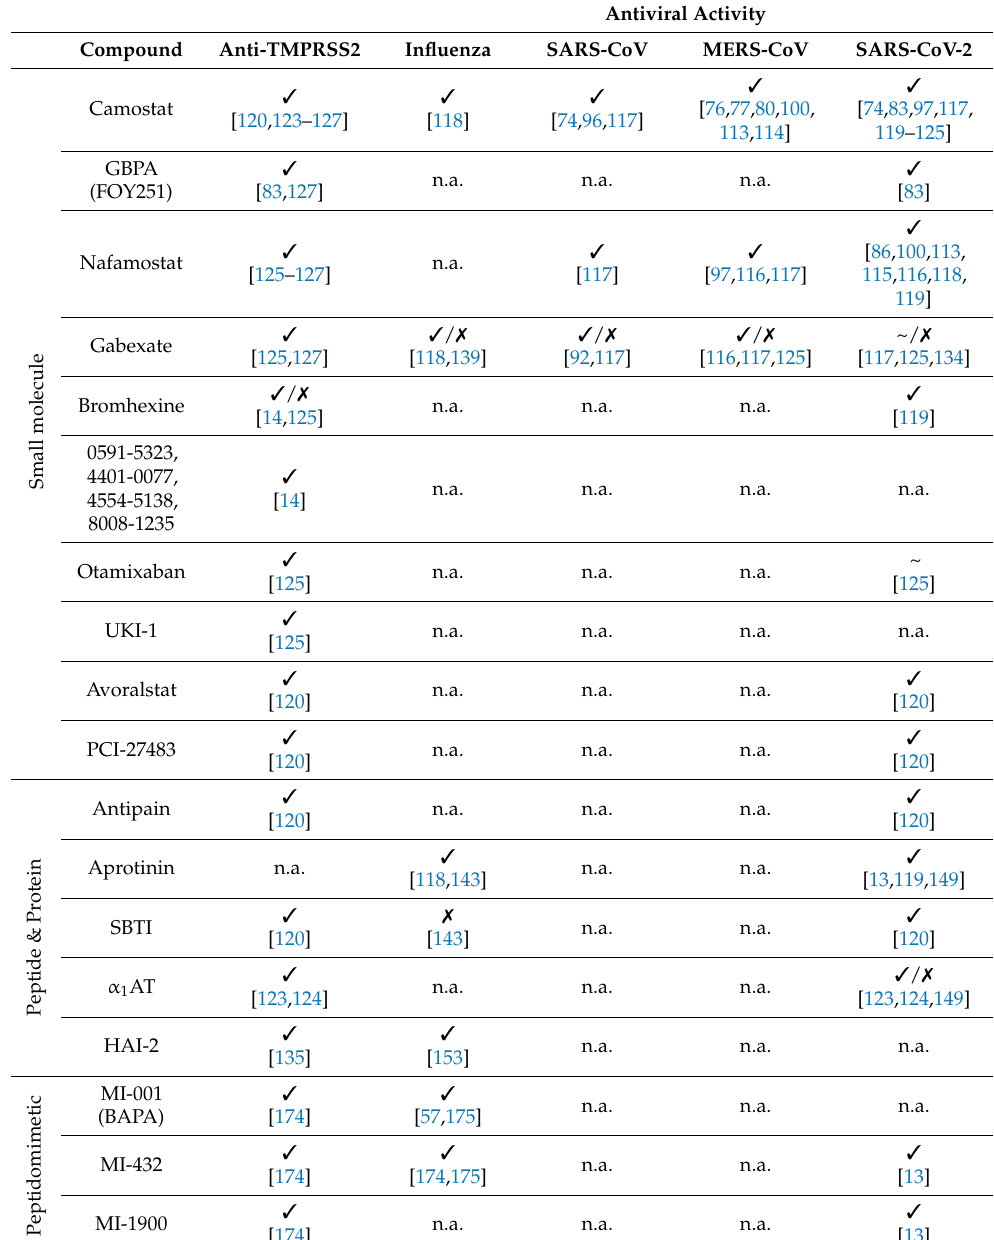
Table 1. Anti-TMPRSS2 and antiviral activity of inhibitors. (cid:51) : Experimentally confirmed anti- TMPRSS2 or antiviral activity; (cid:55) : Experimentally refuted anti-TMPRSS2 or antiviral activity; ~: Exper- imentally confirmed marginal anti-TMPRSS2 or antiviral activity; n.a.: no data